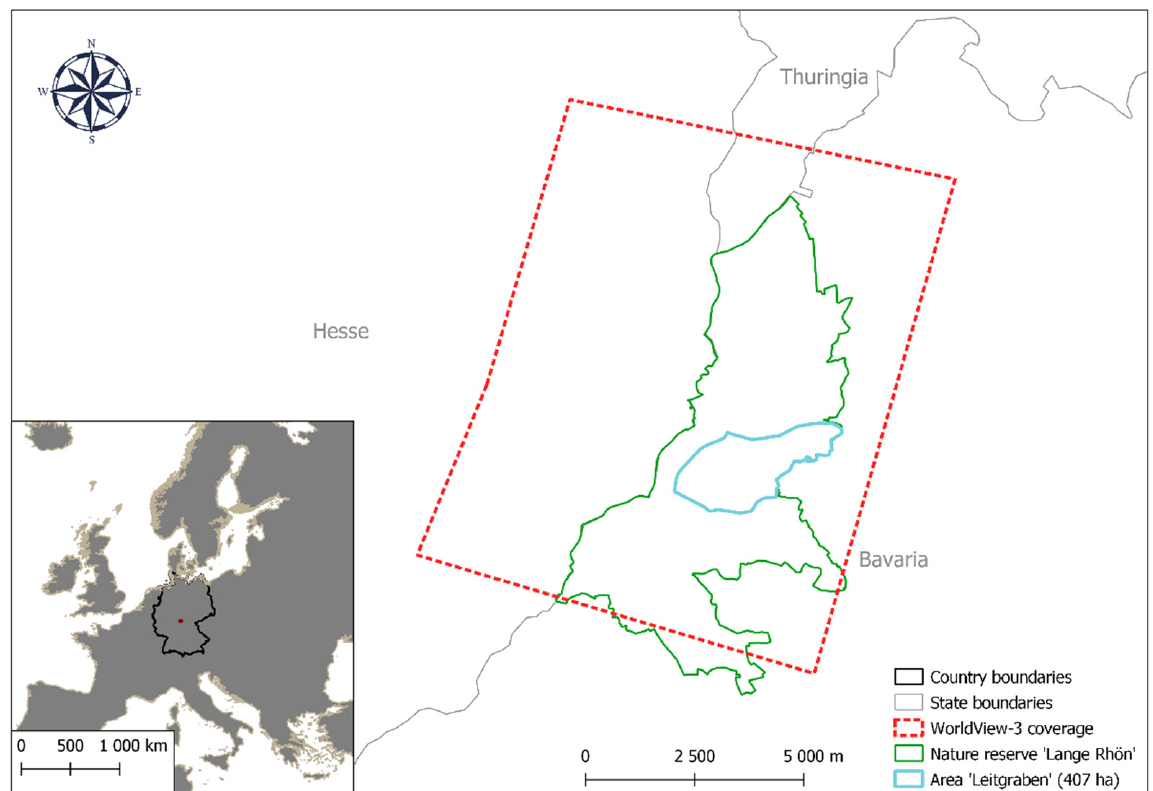
Figure 1. Study area in nature reserve ‘lange Rhön’ in central Germany. Dotted red boundary represents WorldView-3 cov- erage used for training and testing. Blue boundary shows area ‘Leitgraben’ which was selected for the final prediction